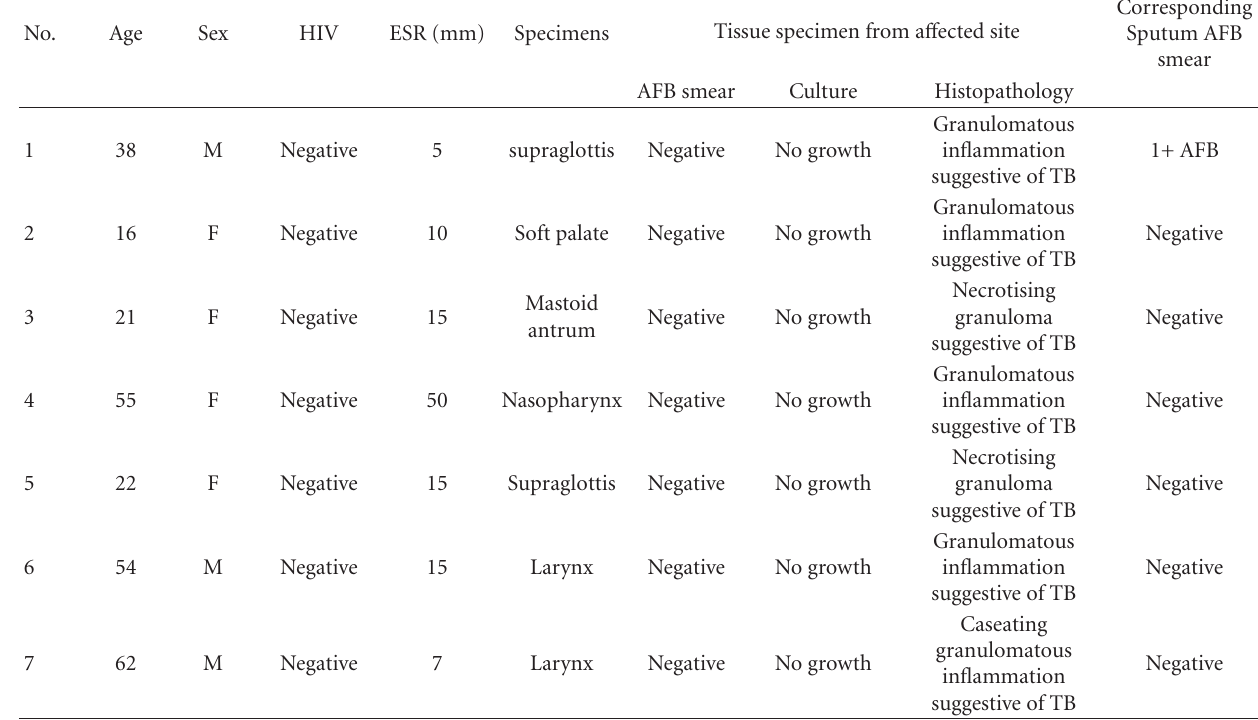
Table 3: Details of seven patients with histopathology-positive and mycobacterial culture-negative otorhinolaryngeal specimens.